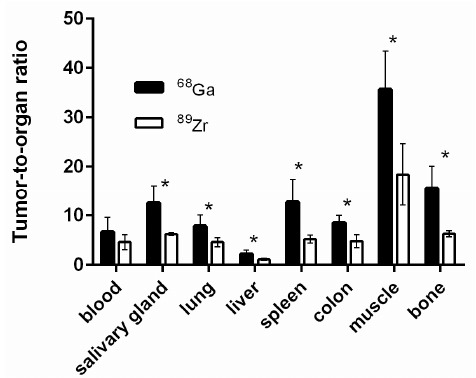
Figure 8. Tumor-to-organ ratios for [ 68 Ga]Ga-DFO-ZEGFR:2377 and [ 89 Zr]Zr-DFO-ZEGFR:2377 conjugates in BALB/C nu/nu mice bearing EGFR-expressing A431 xenografts 3 h after injection. The data were presented as the average (n = 7) and SD. Error bars might not be seen because they are smaller than the symbols. Asterisk (*) marks significant ( p < 0.05) difference.